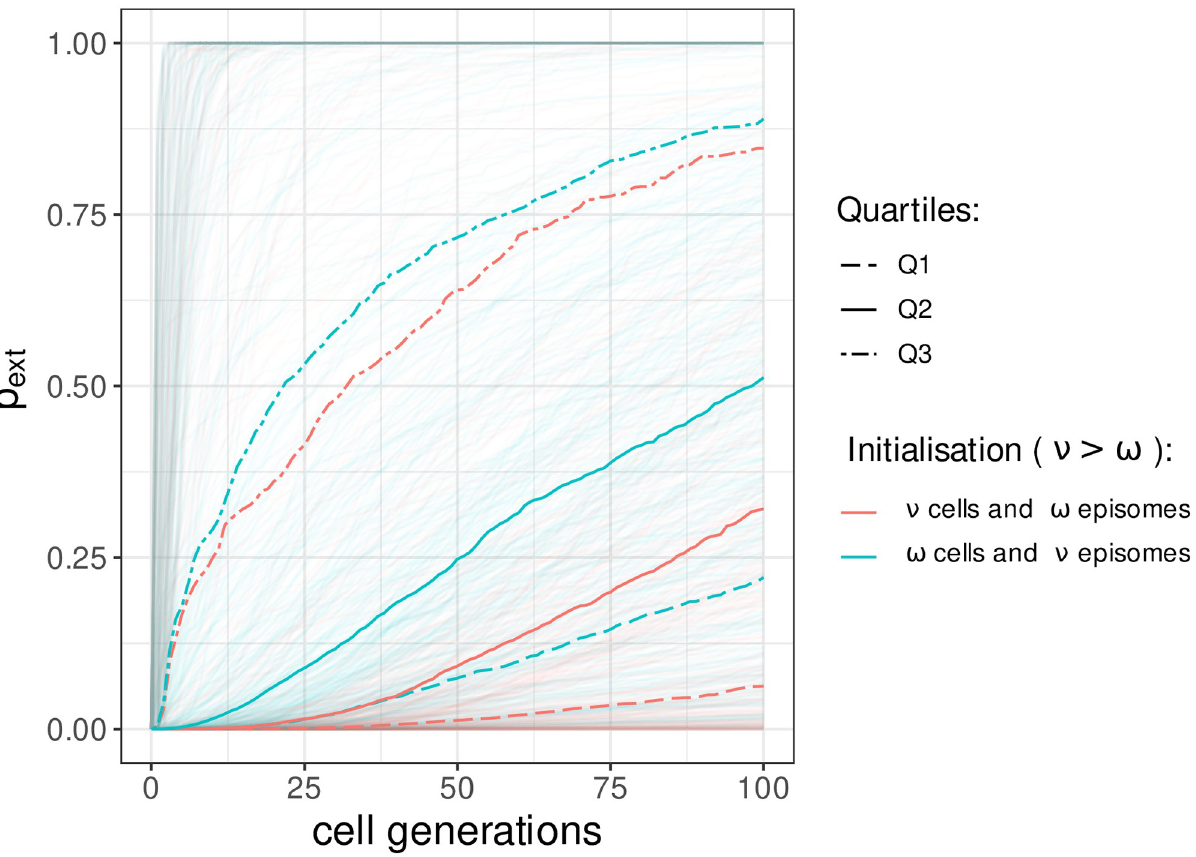
Fig 4. Estimation of the cumulative probabilities of extinction and their quartiles for the two extreme scenarios. In red are displayed the estimations when the N 0 × Γ 0 initial viral copies are allocated in ν cells, each containing ω episomes whereas in blue, the episomes are distributed in ω cells, each containing ν copies ( ν > ω ). The three quartiles are lower for the first scenario, thus indicating a lower risk of extinction when the copies are split in the maximum number of cells